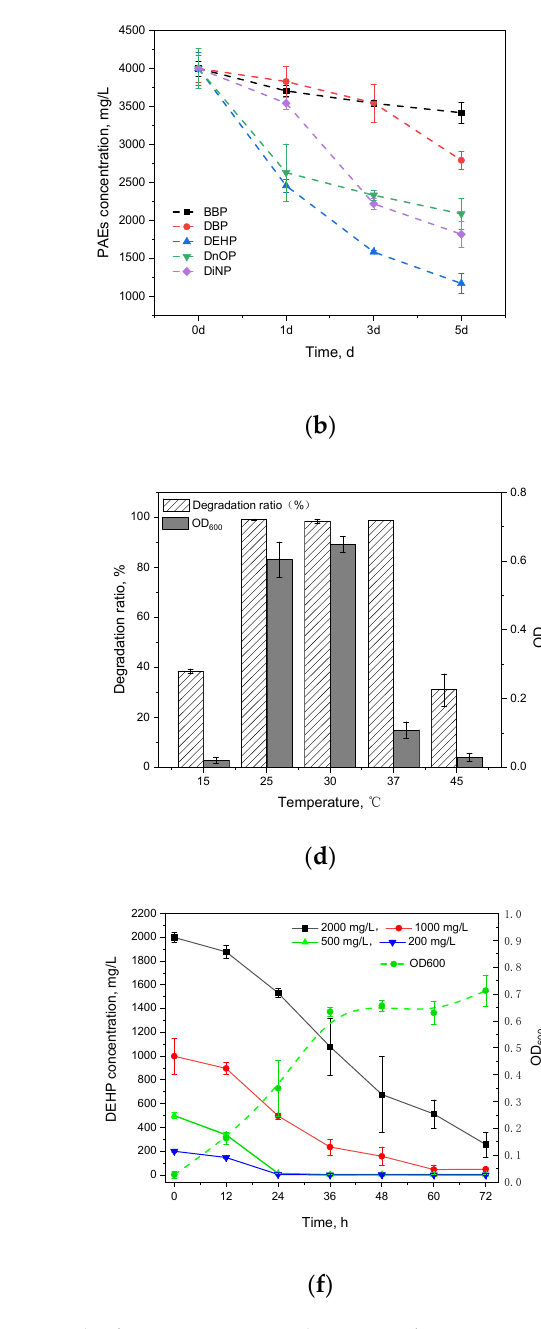
Figure 2. PAEs degradation and the growth of strain GZ-YC7 under 500 mg/L concentration of PAEs for 2 days ( a ); different PAEs degradation ability of GZ-YC7 under a high concentration of 4000 mg/L ( b ). DEHP degradation ratio and the growth of strain GZ-YC7 under different pH ( c ), temperature ( d ), NaCl concentration ( e ), and DEHP initial concentration with growth curves of GZ-YC7 under 500 mg/L DEHP ( f